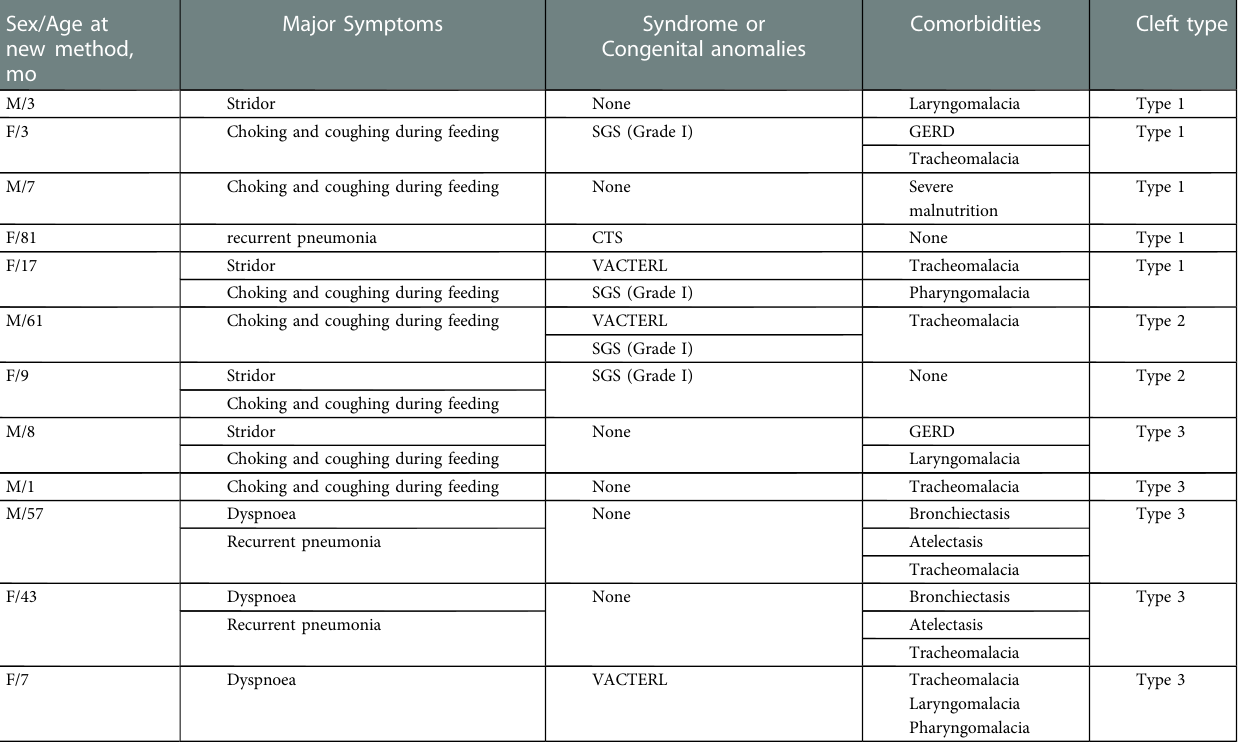
TABLE 1 Characteristics of patients with laryngeal clefts. Sex/Age at new method,